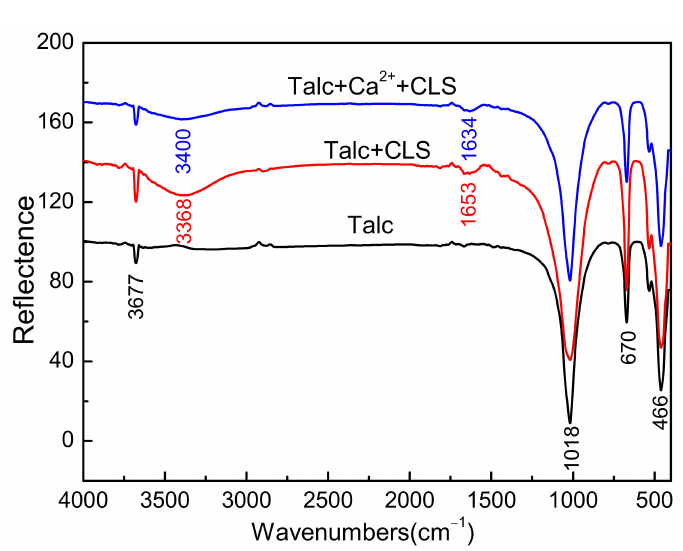
Figure 11. FTIR spectrum of talc conditioned with CLS with/without the presence of Ca 2+